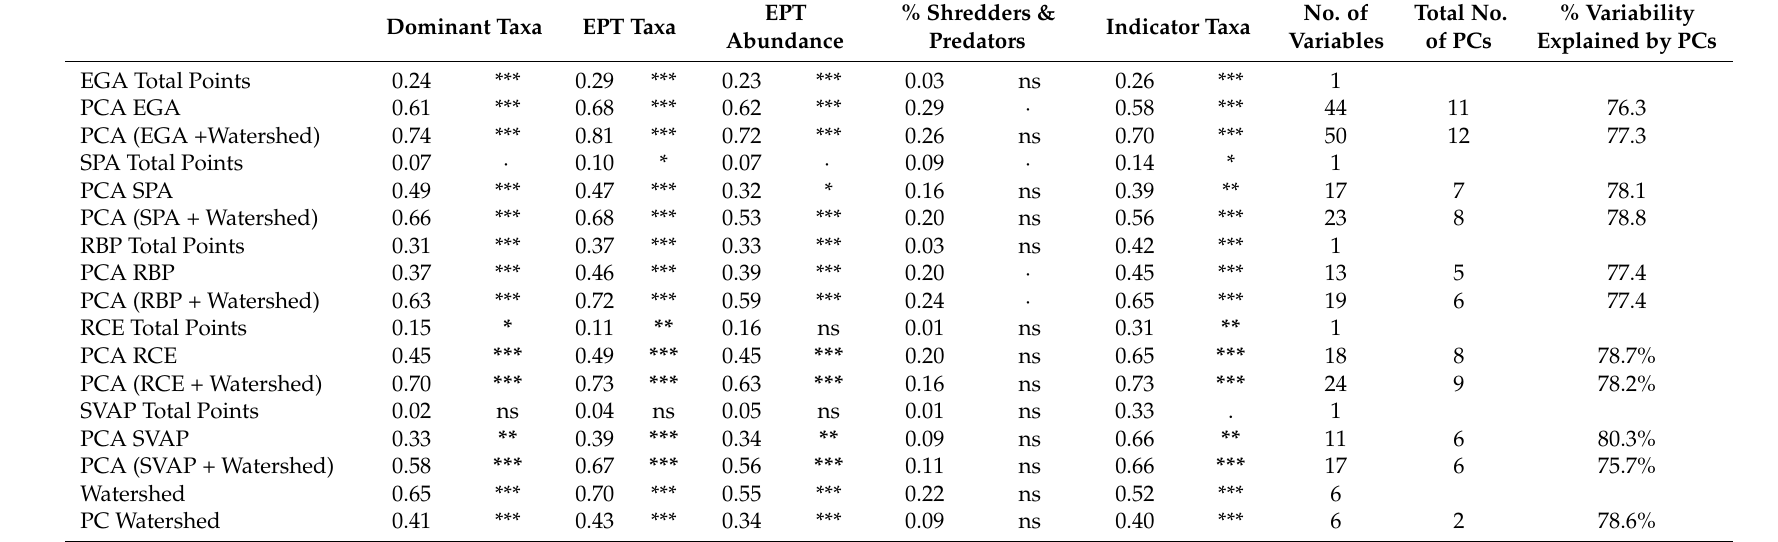
Table 6. Coefficients of determination and significance of the slope based on p -values obtained from linear regression of five macroinvertebrate metrics compared to five stream assessments for 65 streams using three approaches: 1) total raw points, 2) PCA of individual habitat variables and 3) PCA of individual habitat variables combined with six watershed variables. Coefficients of determination are also included from multiple linear regression analyses of five macroinvertebrate metrics to six watershed factors and to watershed PCs (from PCA). Slope significance indicated by *** ď 0.0001, ** ď 0.001, * ď 0.01, ‚ ď 0.05, ns = not